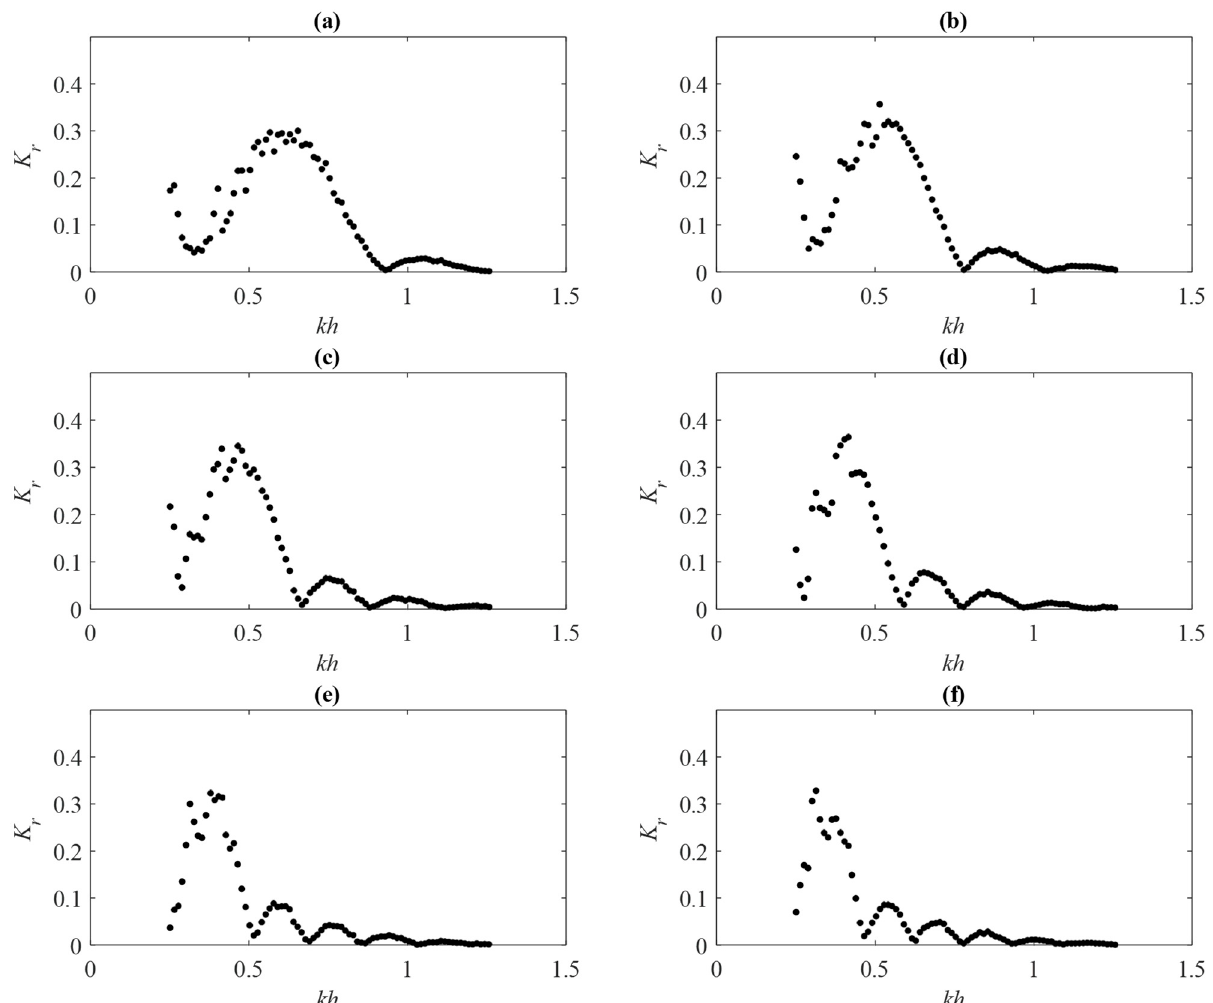
Figure 3. Reflection coefficient of 2 periodically submerged breakwater with different structural wavelengths at 0.2 m water depth. ( a ) 𝑆 = 1.0 m ( b ) 𝑆 = 1.2 m ( c ) 𝑆 = 1.4 m ( d ) 𝑆 = 1.6 m ( e ) 𝑆 = 1.8 m ( f ) 𝑆 = 2.0 m.